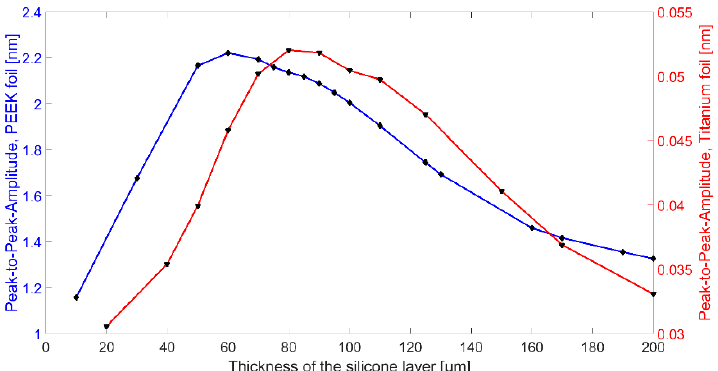
Figure 6. Simulated dynamic displacement of a polyether ether ketone (PEEK) foil (thickness 25 µm, blue curve) or a titanium foil (thickness 32 µm, blue curve) on top of a single CMUT cell with a silicone layer of different thickness, excited with 60 V DC and a single sinusoidal burst at 2 MHz of 15 V AC .